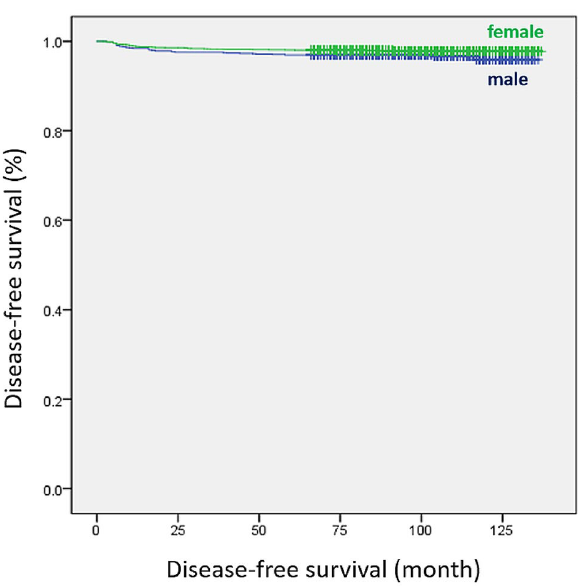
Figure 1. Disease-free survival curves of female and male groups before propensity score matching (log-rank p =